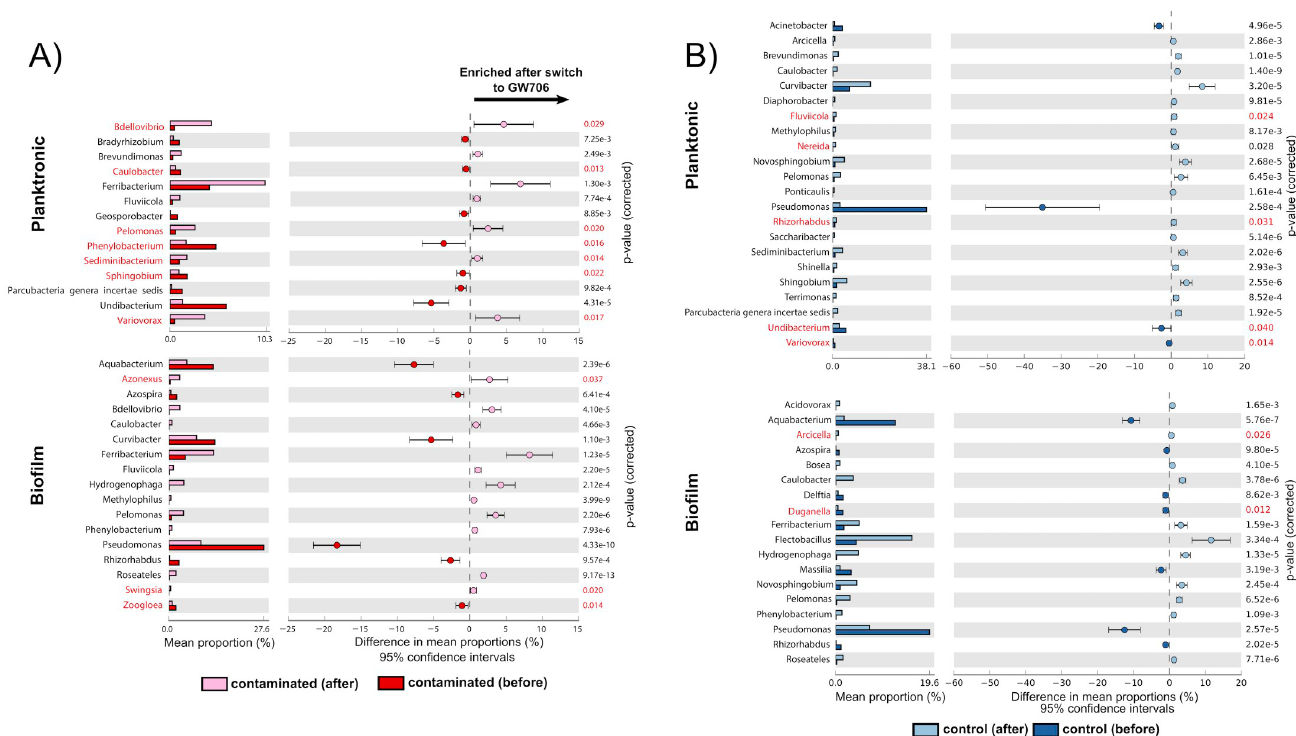
Fig 5. Significant differences (Fisher t-test, > 0.5, p < 0.05) in biofilm and planktonic microbial communities sampled before and after switch from FW305 to GW706 water (t = 18) for A) reactors receiving contaminated water from GW706, and B) control reactors receiving only background water. Genera in red indicates p-value between 0.01 and 0.05, genera in black had p-value < 0.01.